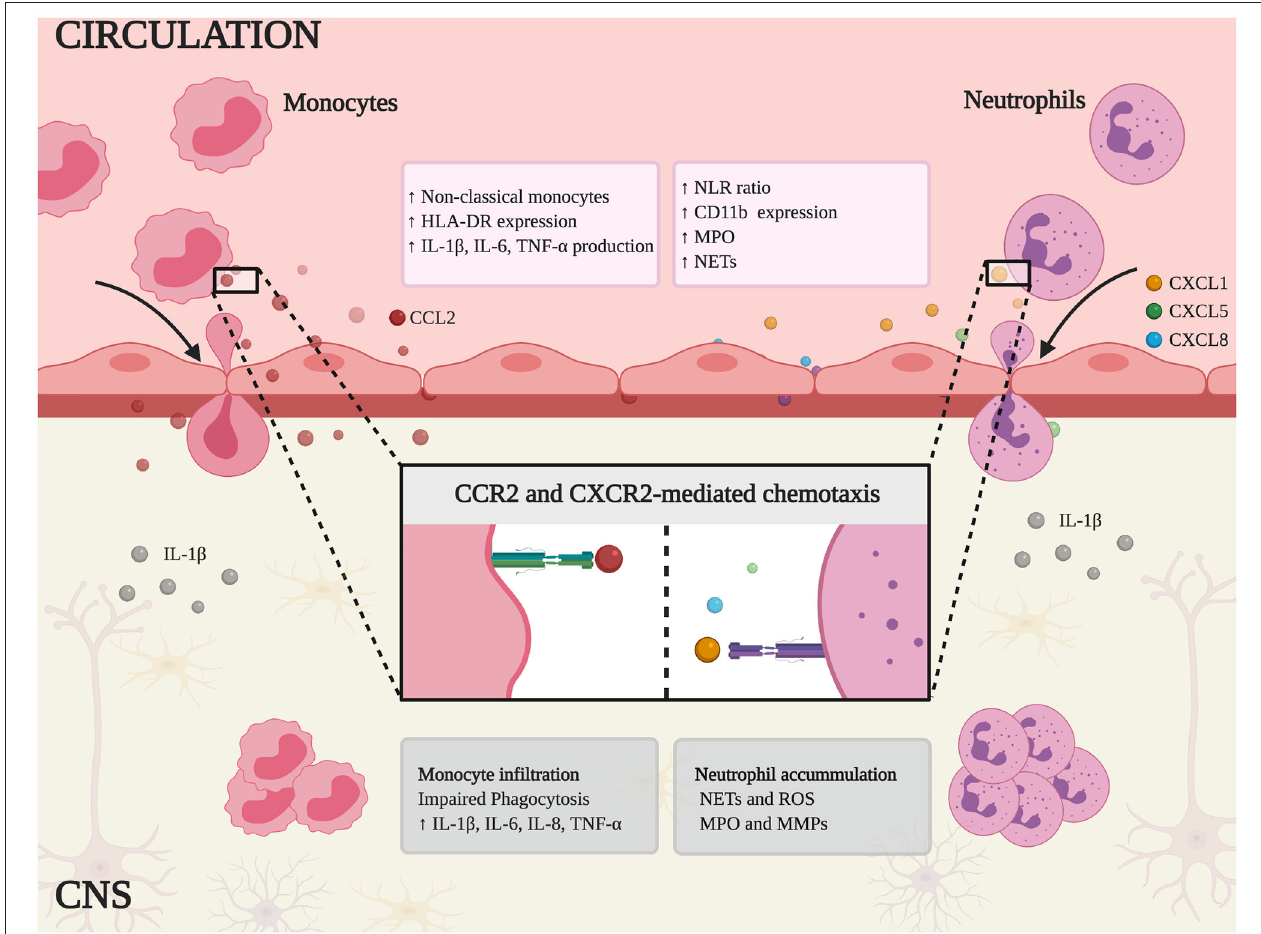
FIGURE 1 | Schematic representation of innate immune mechanisms in MS and AD. Non-classical monocytes and neutrophils are expanded in peripheral blood and the higher neutrophil-lymphocyte ratio (NLR) correlates with the clinical symptoms of each disease. In addition, these cells express canonical activation markers (HLA-DR and CD11b) and release inflammatory mediators, such as pro-inflammatory cytokines (IL-1 β , IL-6, TNF- α ), myeloperoxidase (MPO), and neutrophil extracellular traps (NETs). Chemokine binding stimulates monocytes and neutrophils to infiltrate the CNS by chemotaxis (mediated by CCR2 and CXCR2, respectively). Within the CNS, monocytes show impaired phagocytosis and secrete the pro-inflammatory cytokines IL-1 β , TNF- α , IL-6, and IL-8, thus fueling the inflammatory response. Similarly, infiltrating neutrophils contribute to neuroinflammation and tissue damage by releasing NETs, reactive oxygen species (ROS), MPO, and matrix metal proteinases